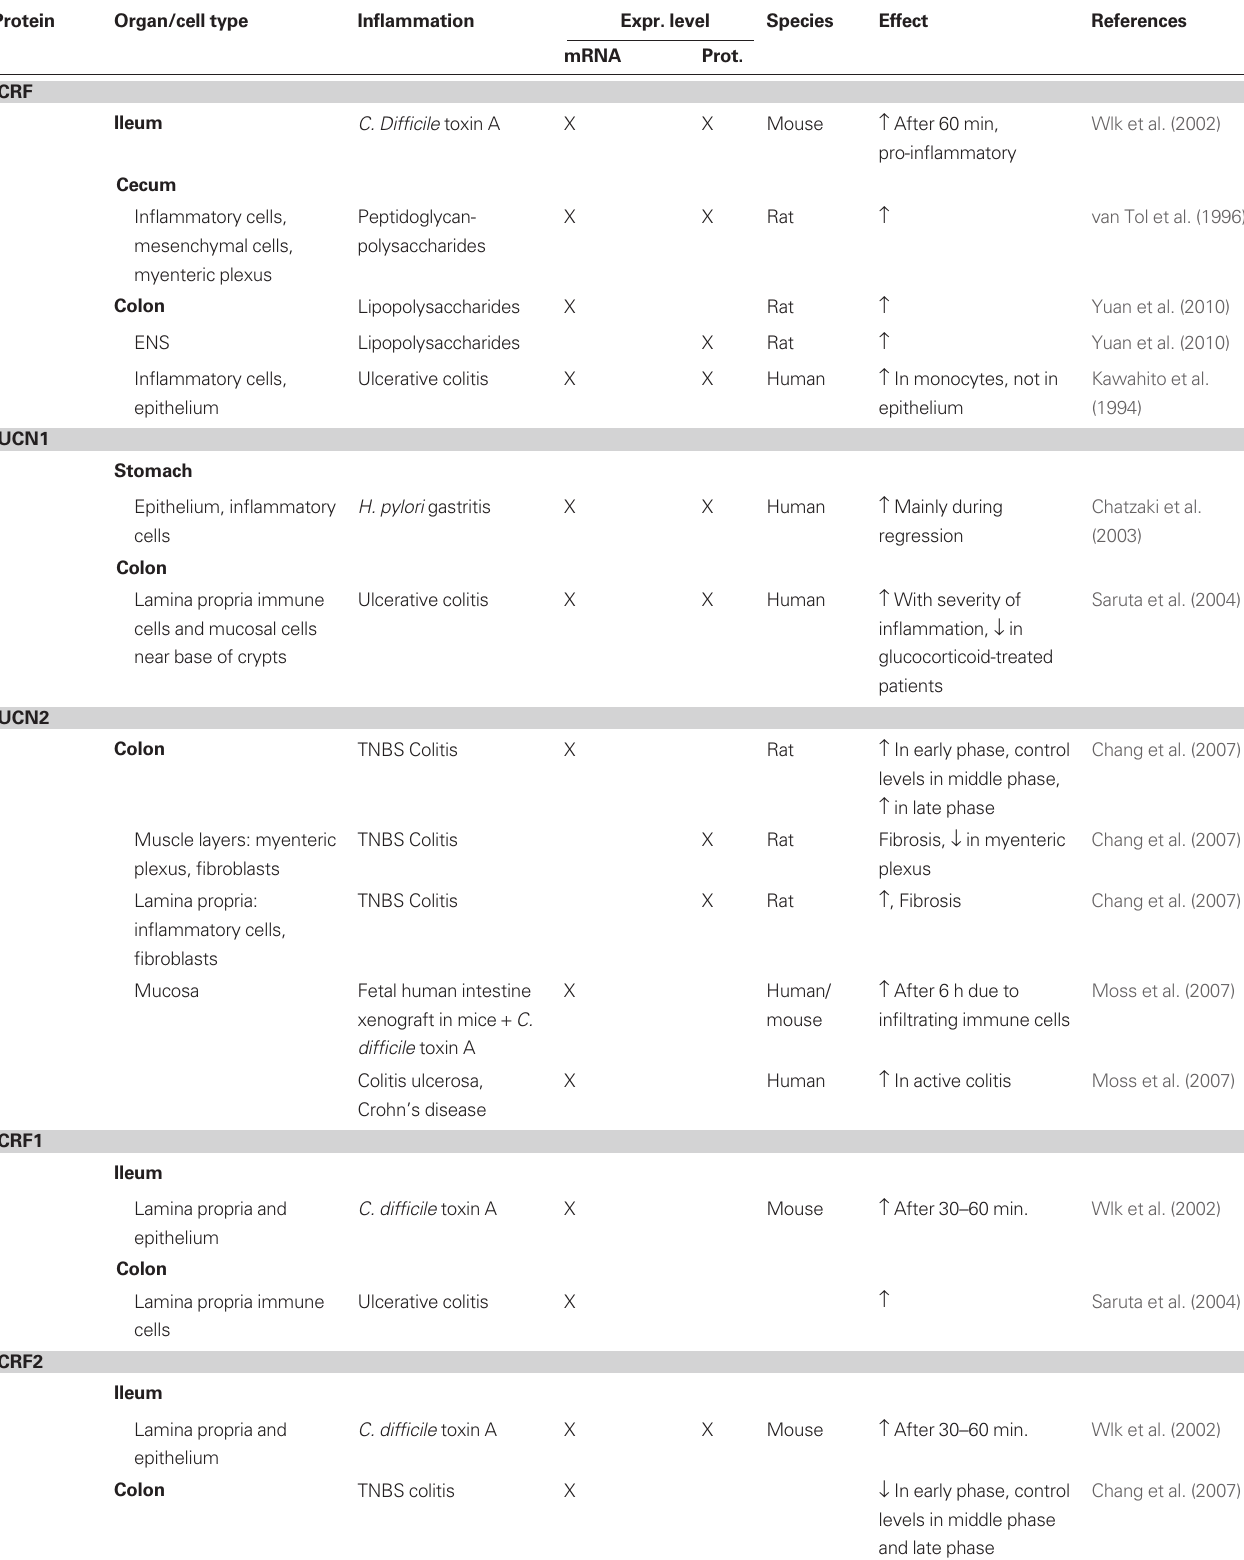
Table 1 | Changes in expression of CrF-related peptides in the inflamed gi tract.